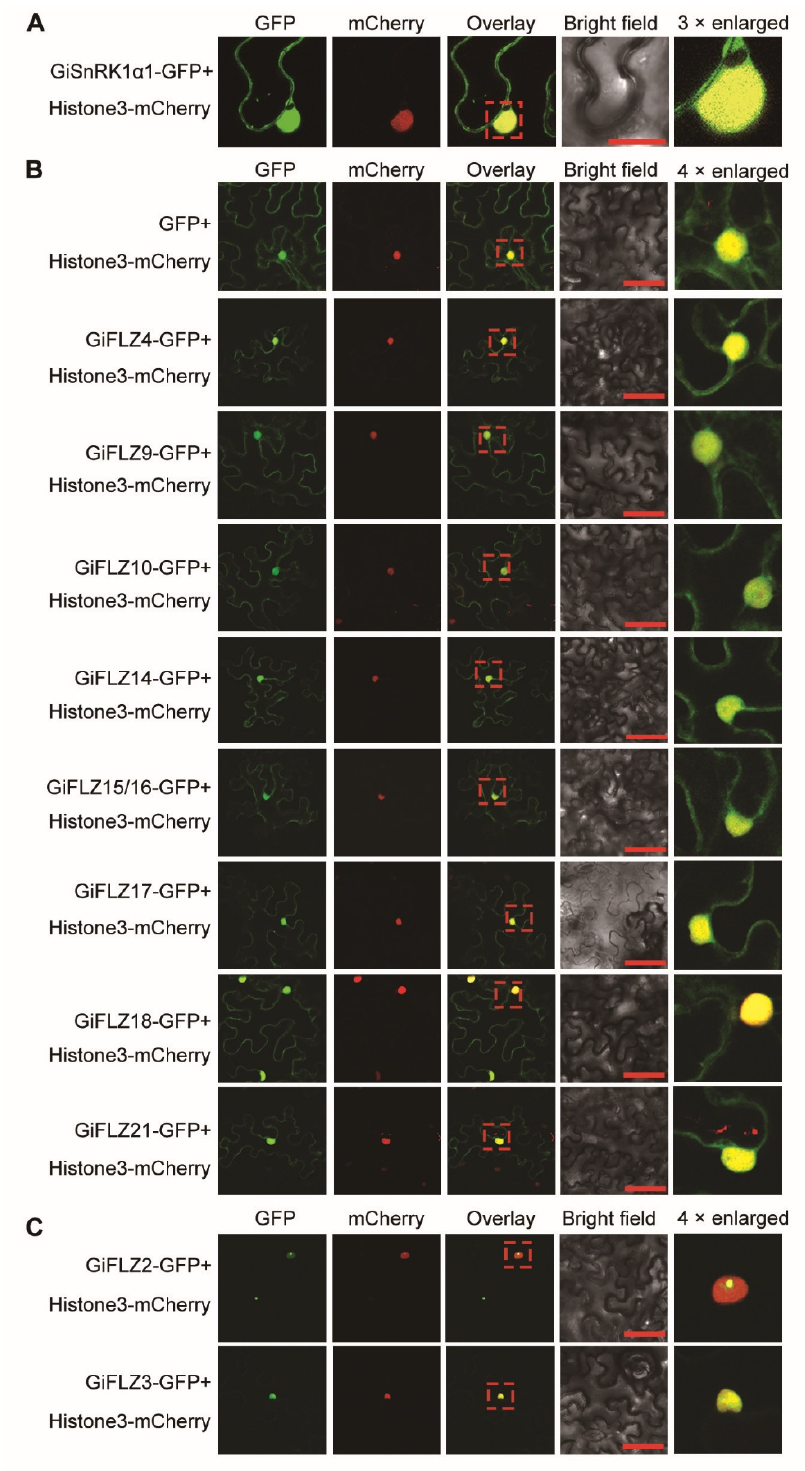
Figure 3. Subcellular localization of GiSnRK1 α 1 and GiFLZs. GiSnRK1 α 1 ‐ GFP ( A ) and GiFLZ ‐ GFP fusion constructs or empty GFP ( B , C ) were transiently expressed in tobacco epidermal cells, respec ‐ tively. Histone3 ‐ mCherry was used as a nuclear marker. Fluorescent images of GFP and mCherry were captured with a confocal scanning microscope and shown in green and red, respectively. Scale bars = 25 μ m in ( A ), and 50 μ m in ( B , C ). The red boxes indicate the enlarged corresponding regions.